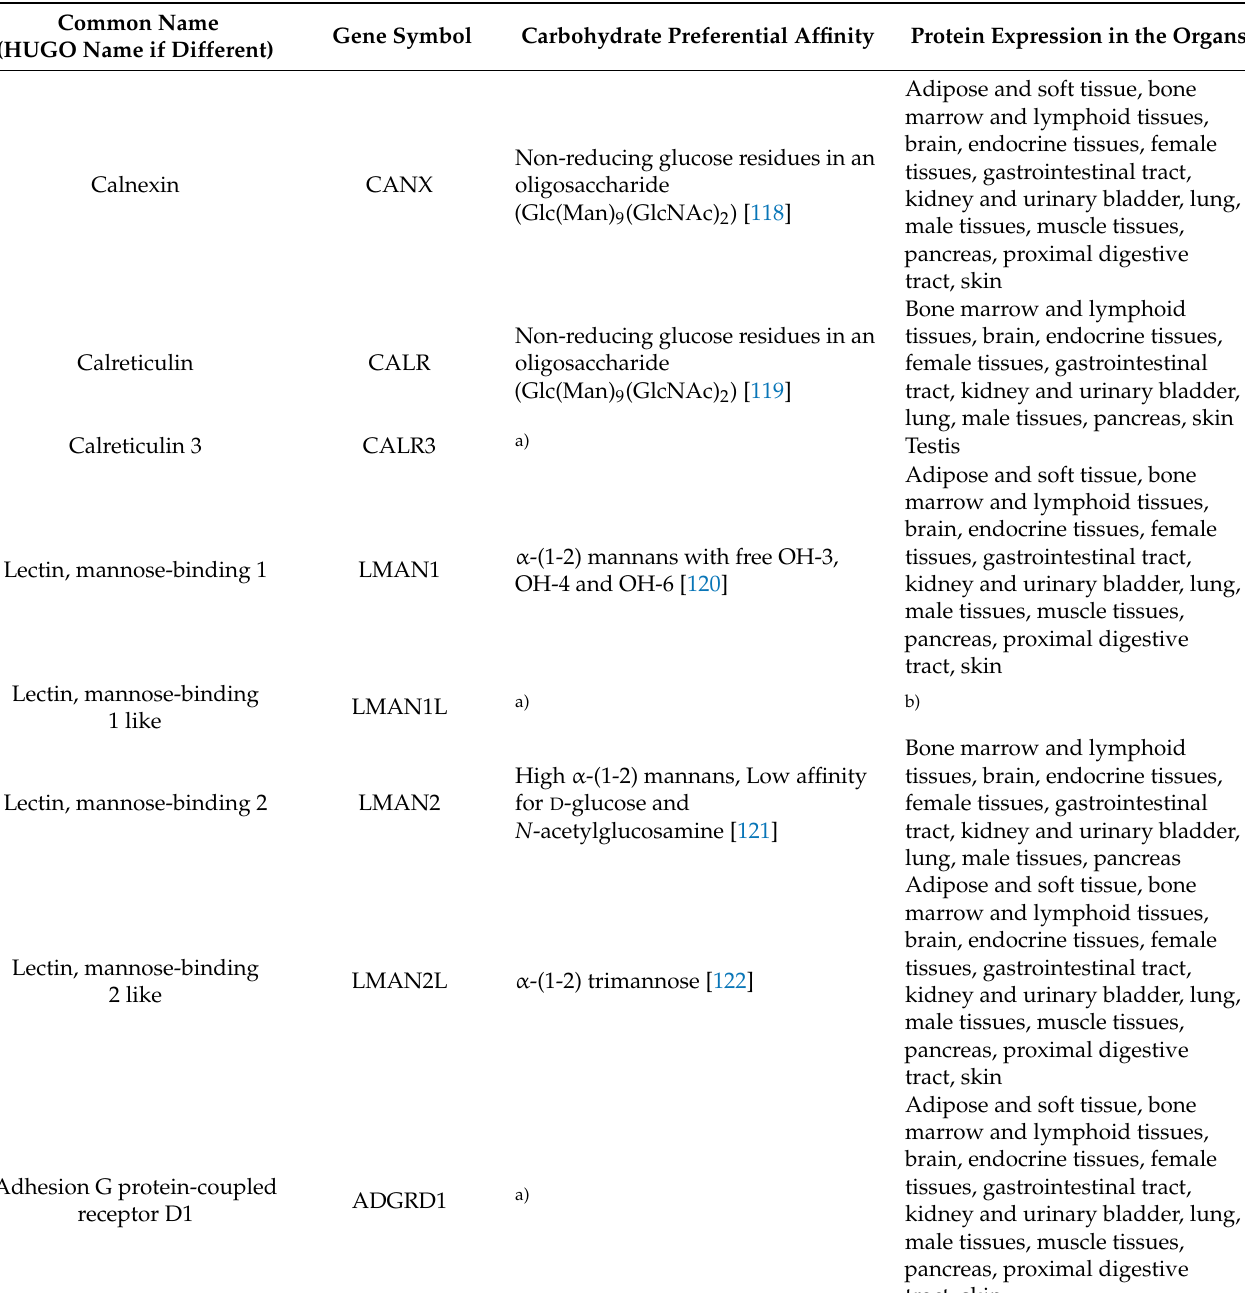
Table 7. Human L-type lectins, their carbohydrate ligands and protein expression in the